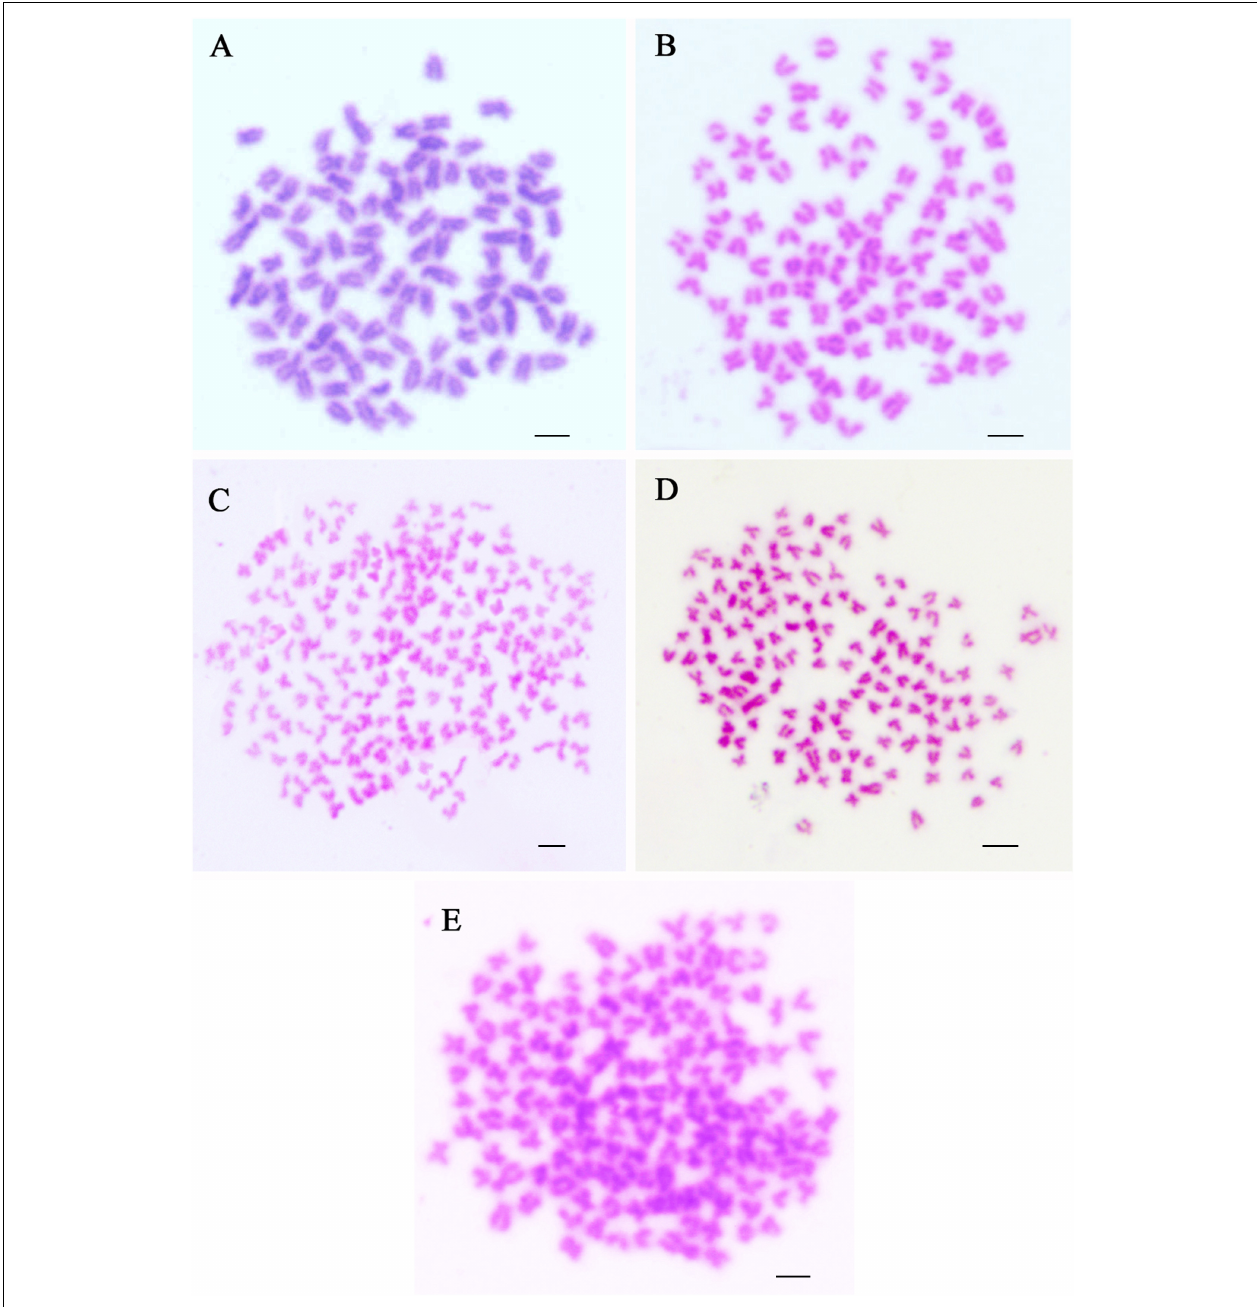
FIGURE 3 | Chromosome spreads at metaphase in RCC, CC, 4nAUT, 3nAUT, and 3nALT. (A) The metaphase chromosome spreads of RCC (2n = 100). (B) Metaphase chromosome spreads of CC (2n = 100). (C) Metaphase chromosome spreads of 4nAUT (4n = 200). (D) Metaphase chromosome spreads of 3nAUT (3n = 150). (E) Metaphase chromosome spreads of 3nALT (3n = 150). Bar in (A–E) , 4 µ m.